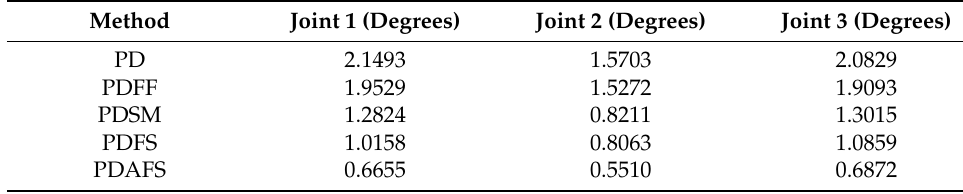
Table 9. RMSE Comparison among the controllers and PDAFS in Helix Case